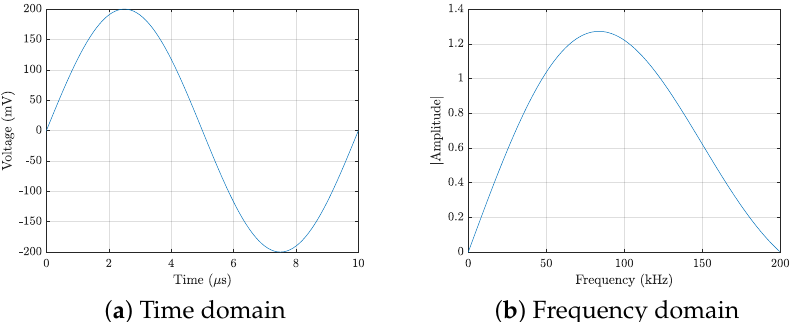
Figure 7. Single cycle sine burst excitation signal centred at 100 kHz.